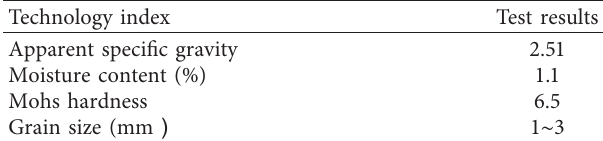
Table 2: Technical indicators of the color